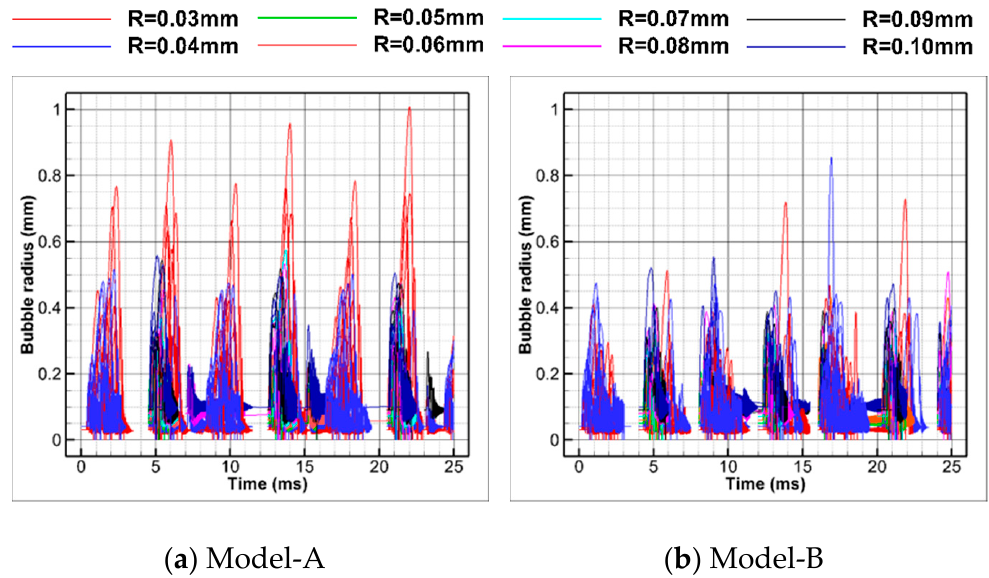
Figure 21. Time histories of the bubble radius of each nucleus according to its size for ( a ) Model-A and ( b ) Model-B.